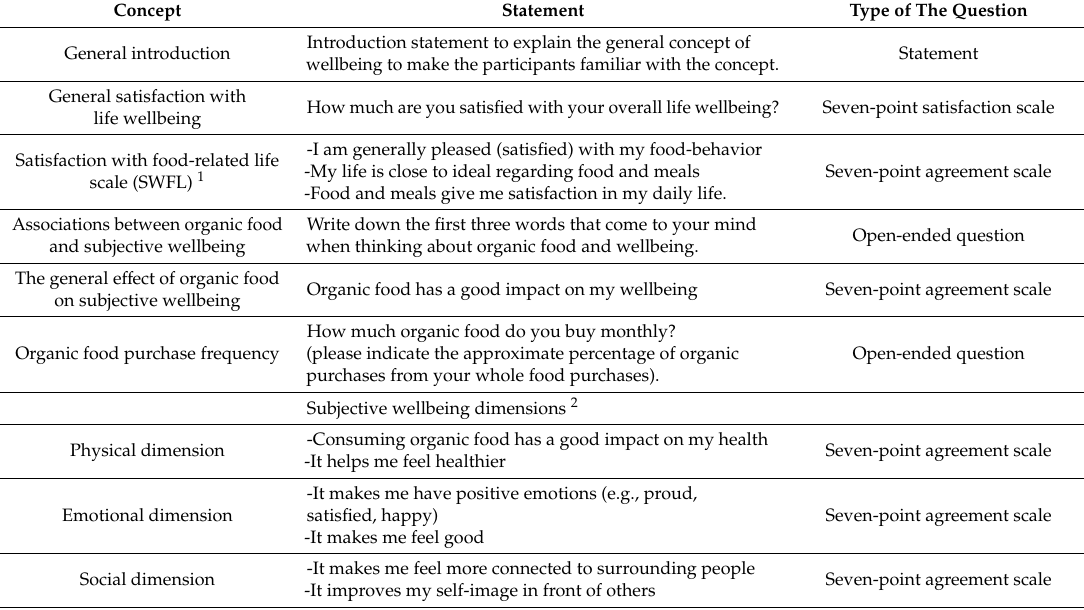
Table 2. The items used in the self-administered survey to evaluate the e ff ect of organic food and the intention-behavior gap in organic food consumption (OIBG) on subjective wellbeing.